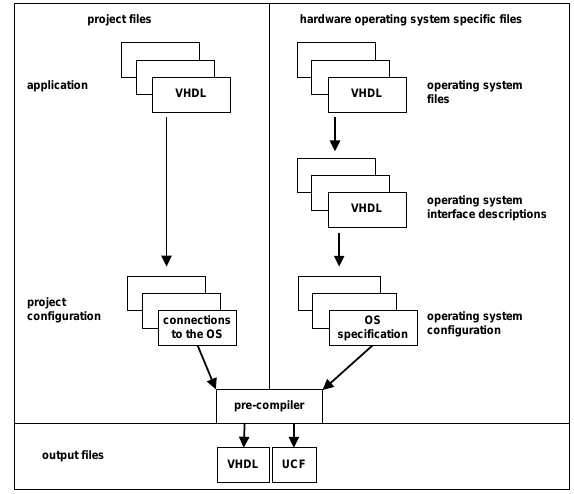
Figure 1: Workflow of the hardware operating system.